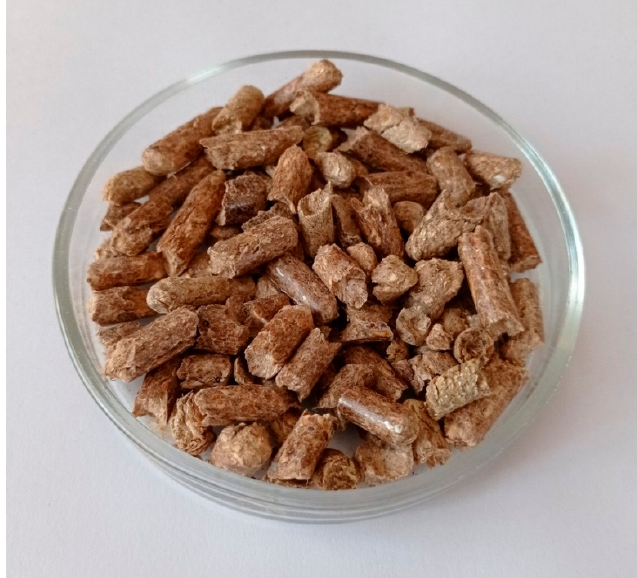
Figure 1. Granules of wheat straw.